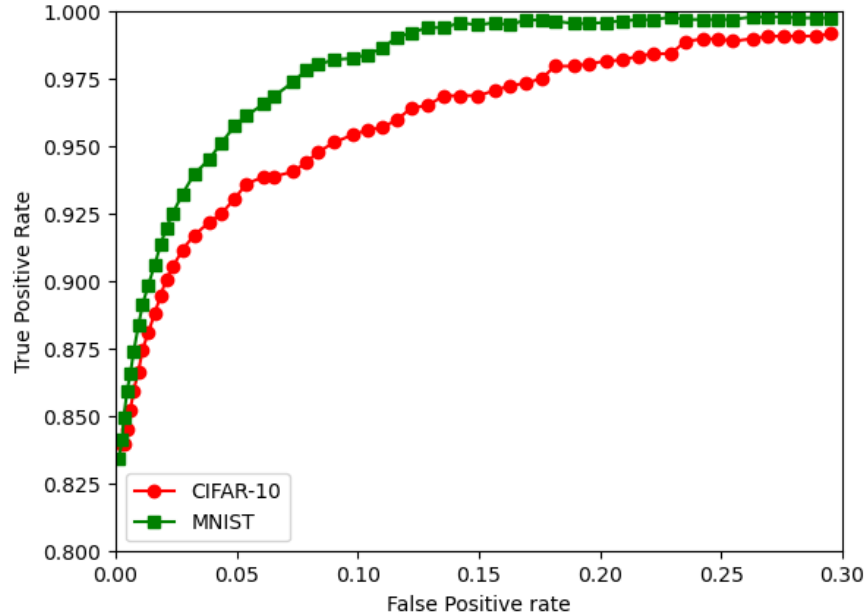
Figure 13. The ROC curves for the CIFAR-10 and the MNIST for the